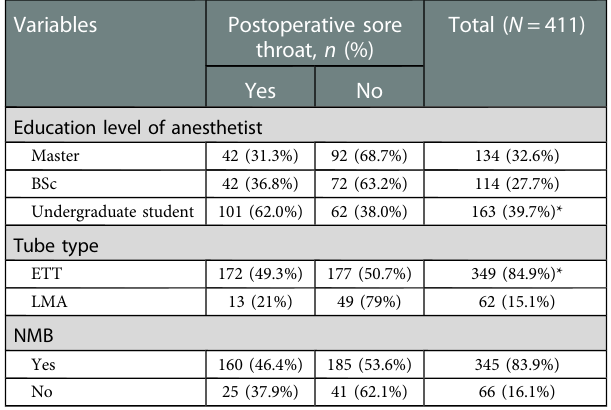
TABLE 2 Anesthesia-related variables of pediatric patients at northwest amhara referral hospitals, from march 1 to June 30, 2022 ( N =411).